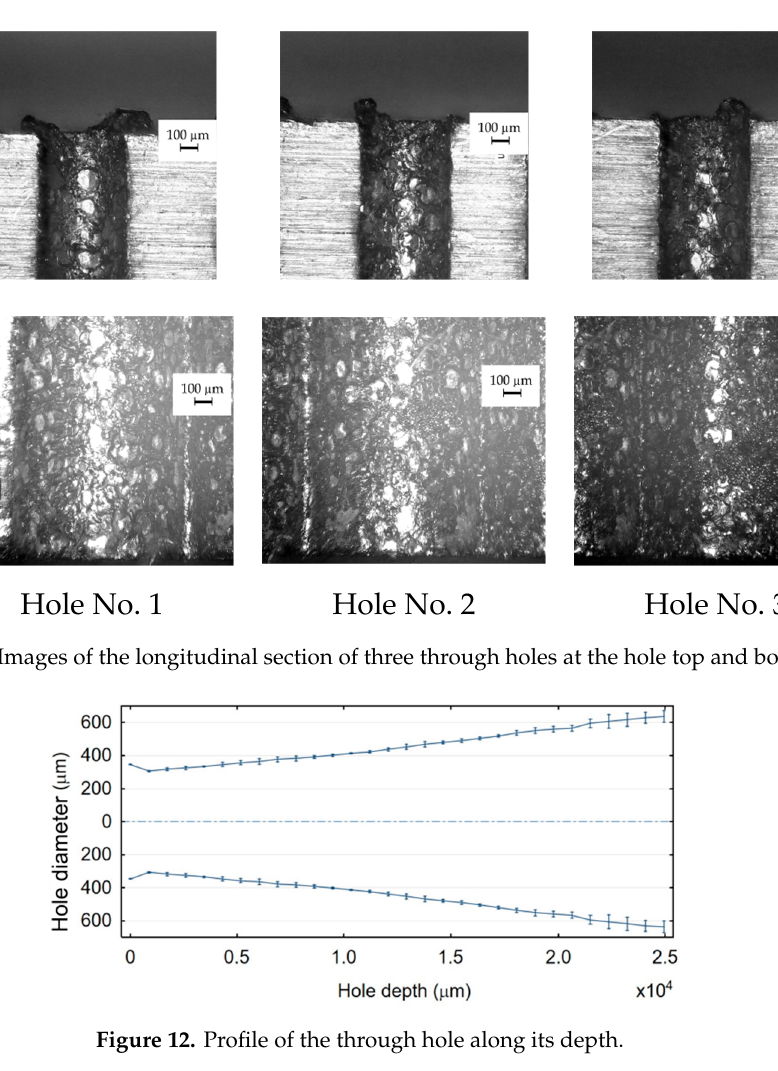
Figure 10. Through holes drilled with the application of the same machining parameters: t i = 282 µs, U = 120 V, I = 4.32 A.